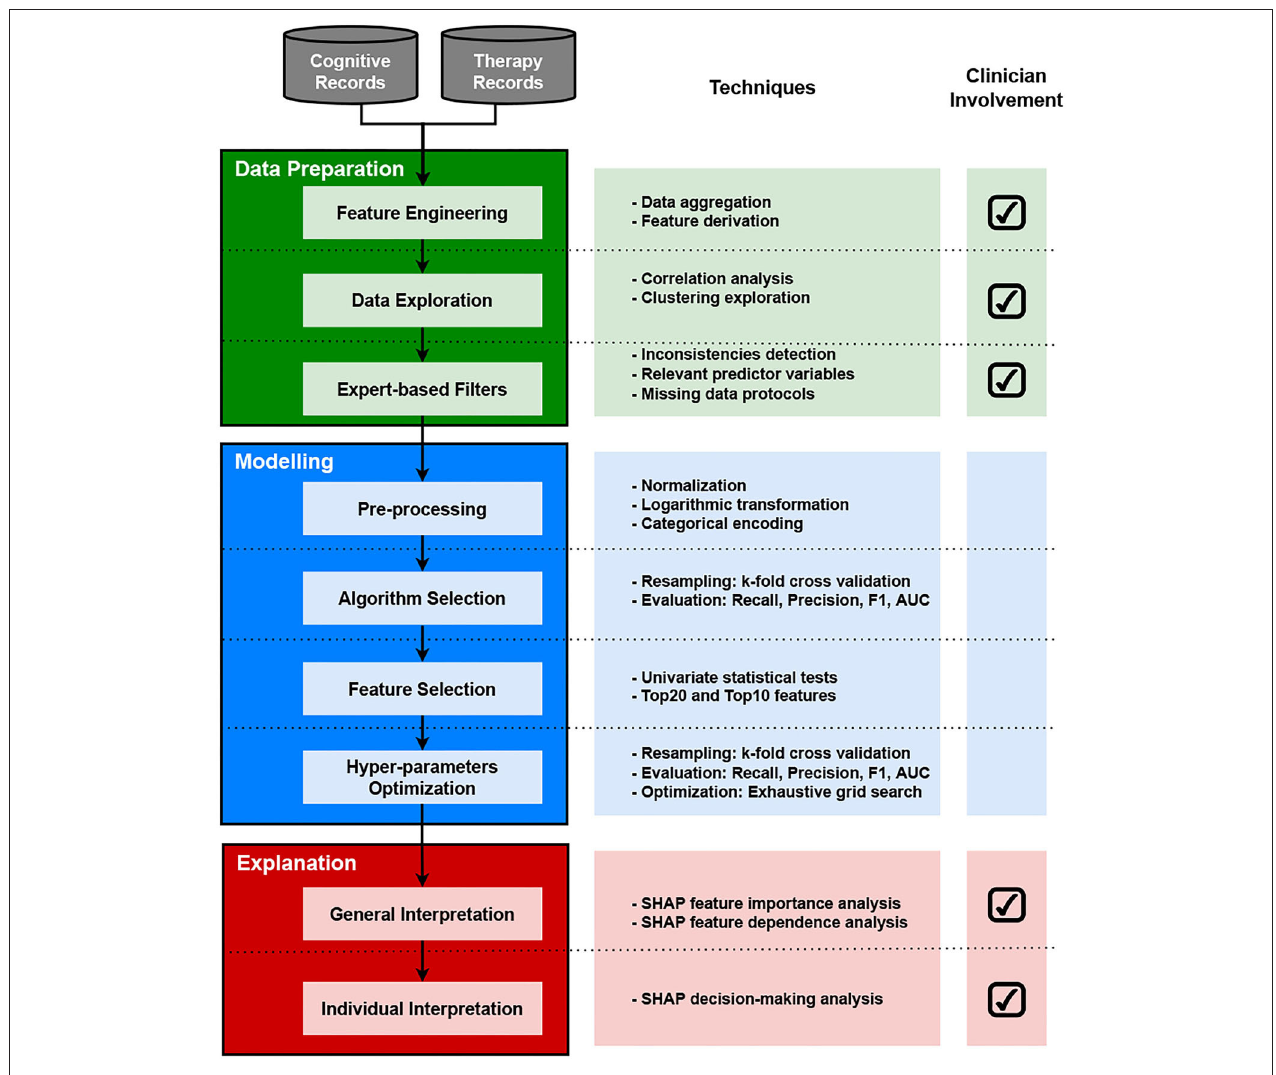
FIGURE 1 | Diagram of the methodology used in this